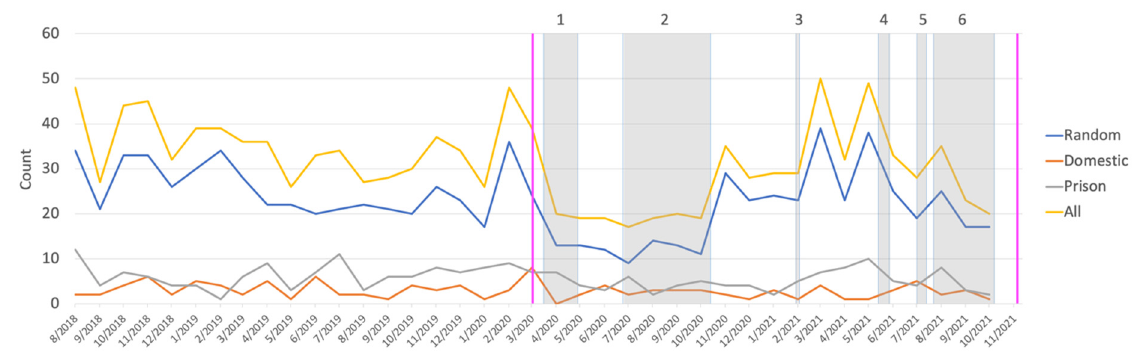
Figure 3. Time series showing the monthly number of assault cases for every assault group and in total. Onset and end of restrictions are indicated by magenta reference lines. Numbered shaded areas represent the Melbourne lockdowns.